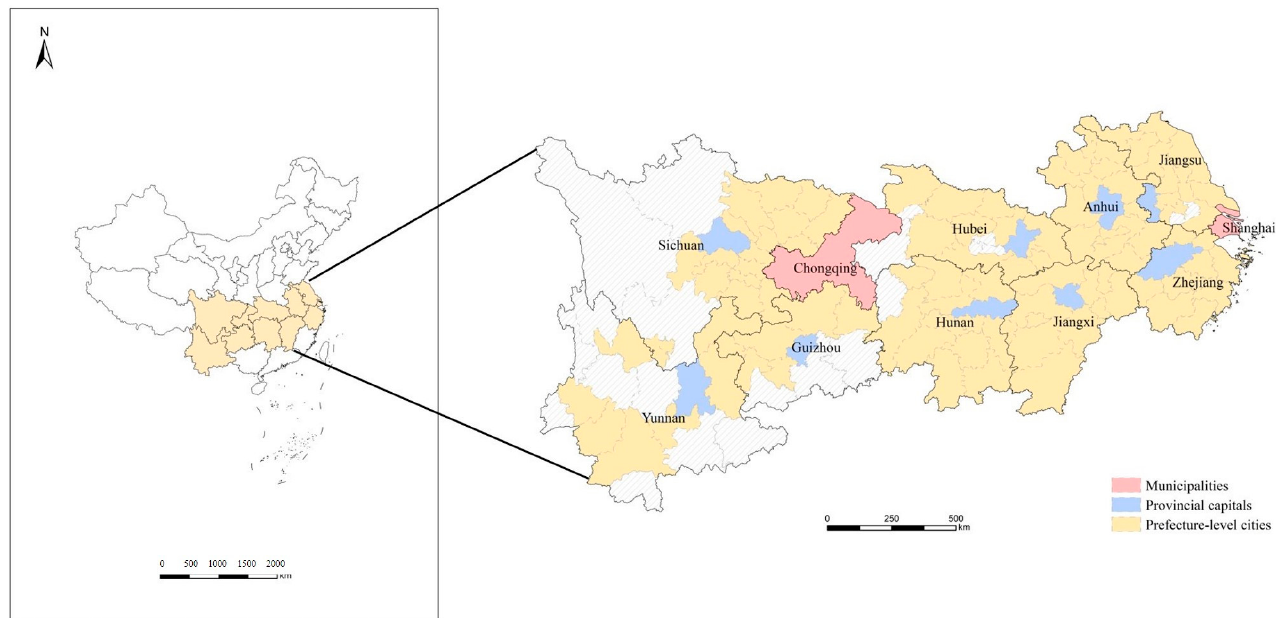
Figure 1. Spatial distribution of municipalities, provincial capitals, and prefecture-level cities in the Yangtze River Economic Belt (YREB).